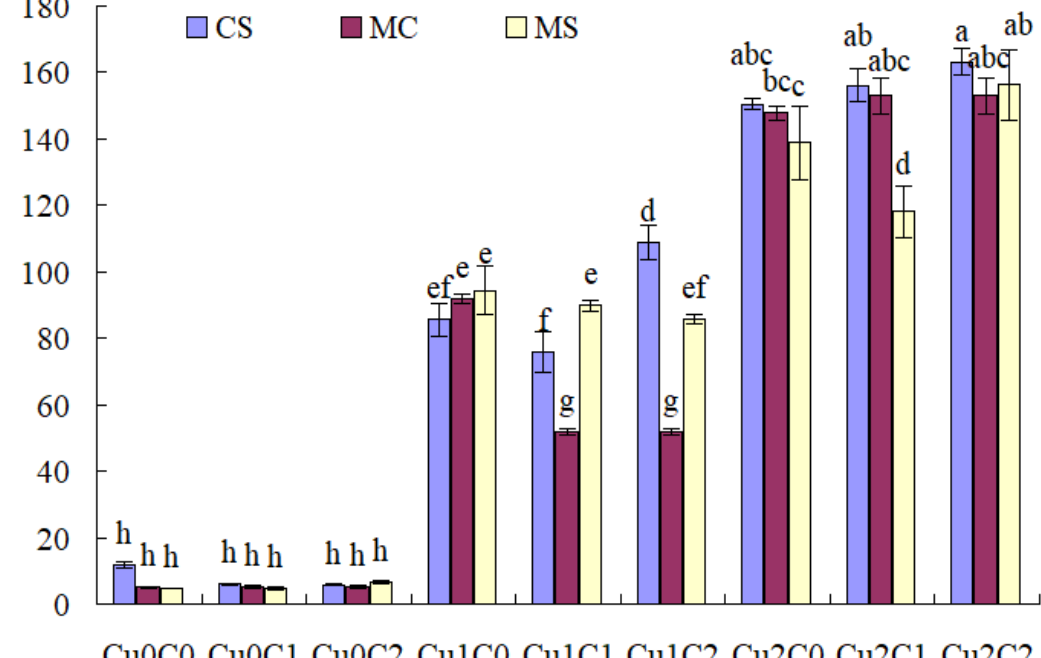
Figure 1. Soil acid-soluble copper concentration under different treatments. The different small letters above each column mean significantly different at p < 0.05.